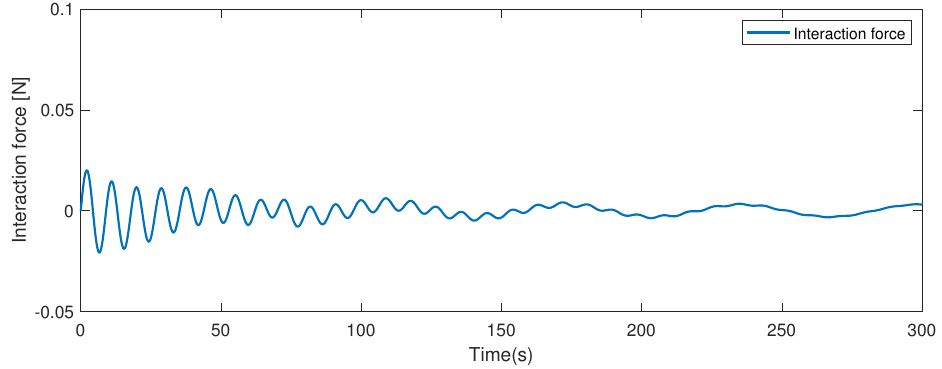
Figure 12. The interaction force of the